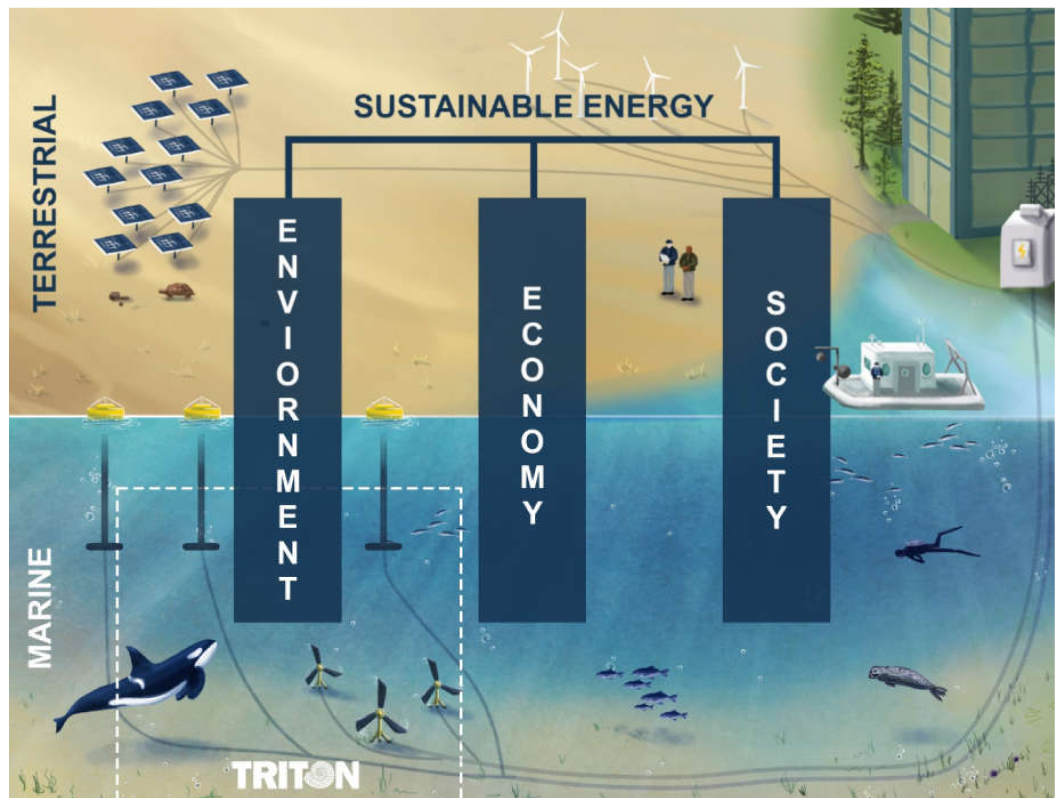
Figure 3. The three pillars of sustainability and sustainable energy applied to marine energy (ME), with the segment of the marine environment covered by the Triton Initiative highlighted. The TFiT results are a vital to ensuring minimal impact on the marine environment by ME deployment. However, life cycle environmental, economic, and social considerations for marine and terrestrial settings must be evaluated and considered (illustration by Stephanie King, PNNL).